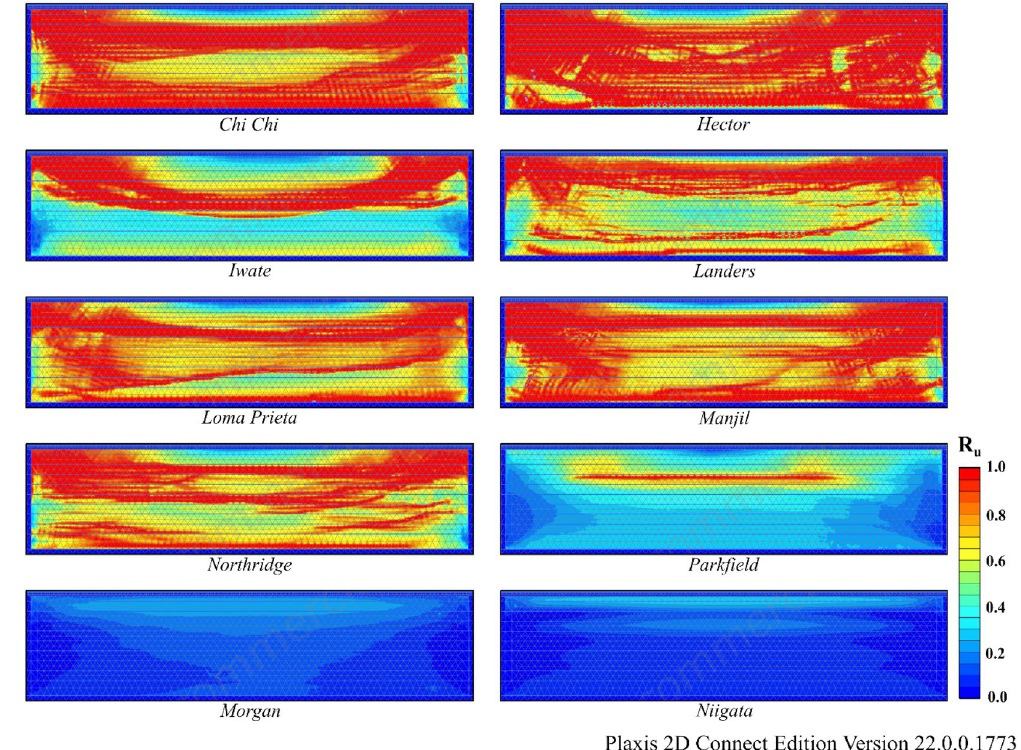
Figure 15. R u results obtained at the end of the vibrations for Model